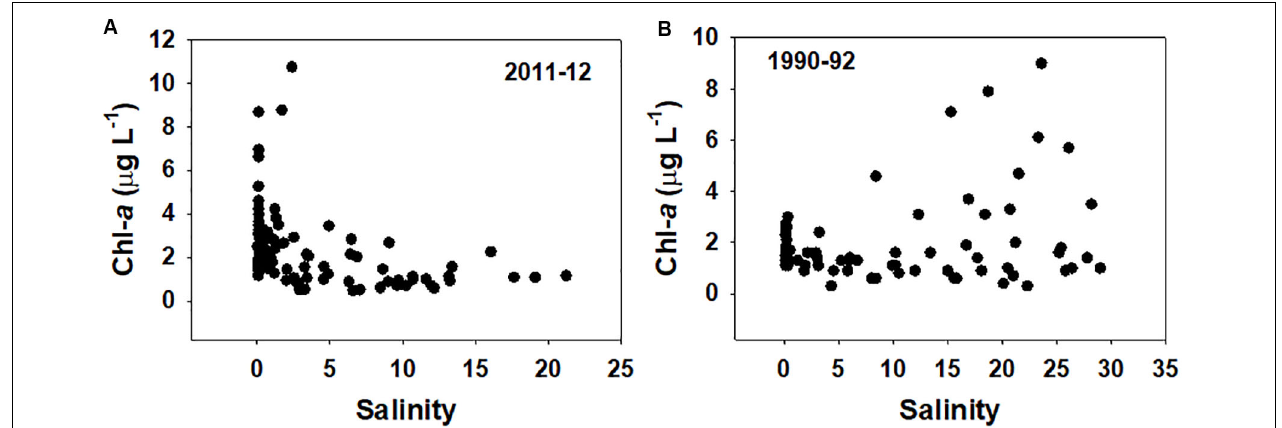
FIGURE 2 | (A) All chlorophyll data from this study plotted vs. salinity for the 2011–2012 water year. (B) Chlorophyll data for northern San Francisco Bay Estuary (SFBE) sites vs. salinity from 1990 to 1992 (Cloern et al., 1993; Canuel et al., 1995).